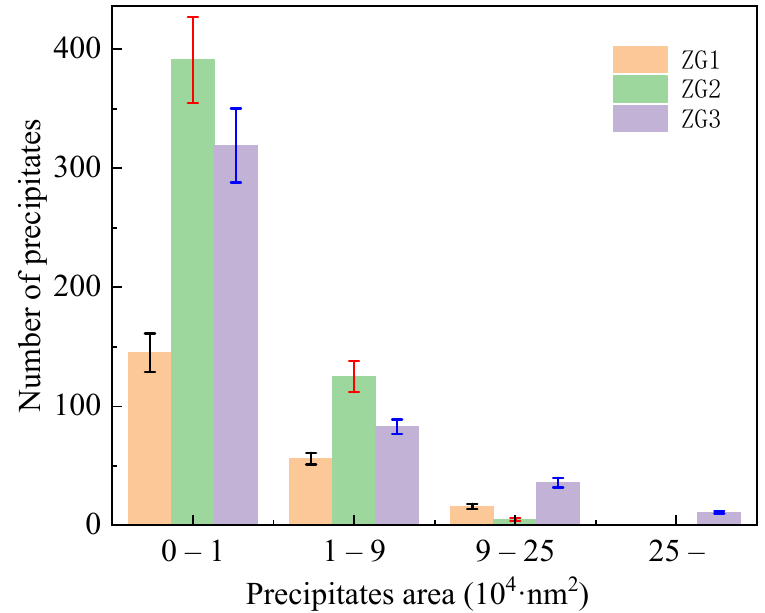
Figure 7. Statistics of the number and area size of precipitates after the thermal fatigue cycle. Variations in precipitate size and distribution dictate subsequent fatigue properties of the material as it substantially depends on precipitate morphology and interaction with plastic deformation bands or micro-cracks in a particular microstructure. Particularly, the ZG1 and ZG3 materials have fairly huge and uneven precipitates in terms of size, how- ever, the nano-precipitates are uniformly tiny and regular in ZG2. 3.3. Crack Tip Morphology The microstructure morphology, element distribution, and precipitates morphology around the crack tip of materials ZG1, ZG2, and ZG3 were compared and analyzed to study their potential cracking resistance. The structure and precipitates of the crack tip were analyzed by SEM and ZG1 and ZG2 demonstrated branching phenomena at the crack tip, as illustrated in Figure 8a,b. The crack tip of ZG1 is sharp, and the angle of the bifurcation is about 45°, while the crack tip and bifurcation are arc-shaped in ZG2. Re- sistance to cracking with an arc-shaped tip is greater than that of the acute-angle tip with better thermal fatigue resistance. The smaller the angle of the bifurcation, the more likely the metal in the bifurcation would cause stress concentration and accelerate crack propa- gation. The crack tip area is further enlarged for a more visible view, as shown in Figure 8c,d.